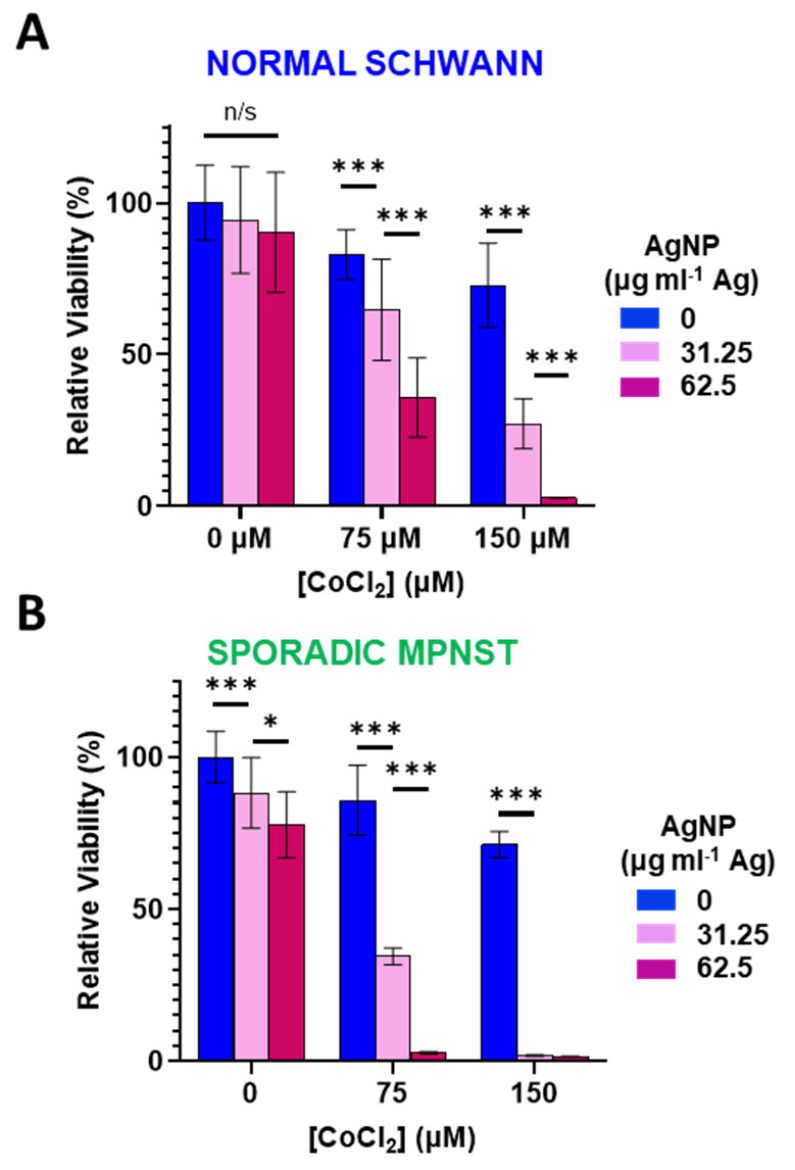
Figure 3. Cobalt chloride-induced hypoxic/oxidative stress sensitizes normal Schwann cells and sporadic NF1-wildtype MPNST to AgNP treatment. ( A ) Normal Schwann cells (iHSC1 λ ) or ( B ) sporadic NF1-wildtype MPNSTs (STS26T) were exposed to CoCl 2 and AgNPs for 48 h, and viability was assessed by MTT. Data are shown ± SD and are representative of three independent experiments. Significance between treatments was determined by Student’s t -test (*** p < 0.005, * p < 0.05, n/s not significant).